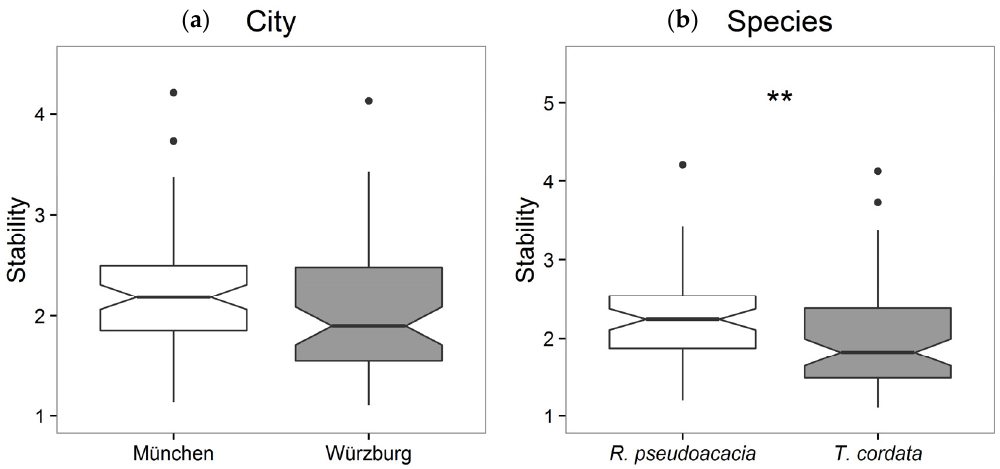
Figure 3. Boxplots showing the relationships of growth stability with city ( a ) and species ( b ). Significances are marked by asterisks.